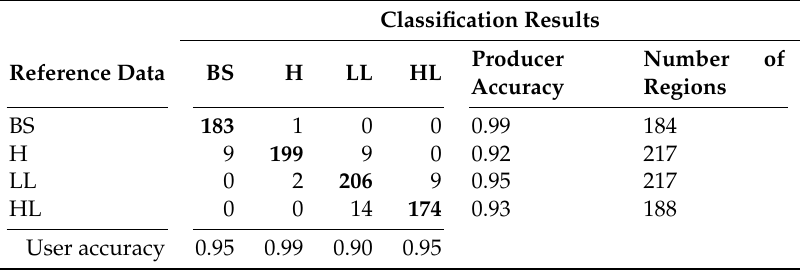
Table 4. Confusion matrix of the vegetation map (BS: bare soil, H: herbs, LL: low ligneous, HL: High ligneous). Well classified regions appear in bold.